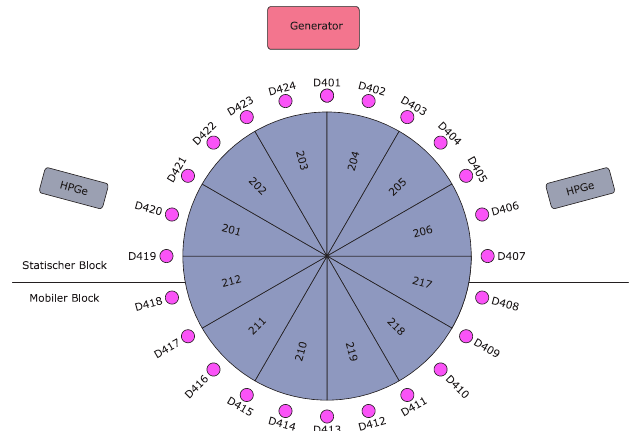
Fig. 2. Sketch of the measurement plane of the QUANTOM ® device. Neutrons are produced in the neutron generator on top and generate gammas via (n, γ ) reactions. These are recorded by the two HPGe detectors. All possible neutron detector positions within this plane are indicated by magenta circles. Not shown are all internal details like moderator, collimator and radiation